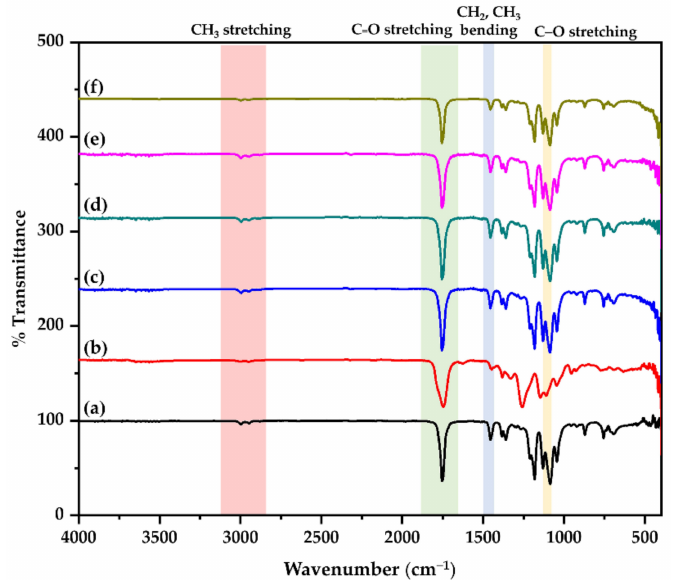
Figure 3. FT-IR spectra of homopolymers and graft copolymers with composition ratios of